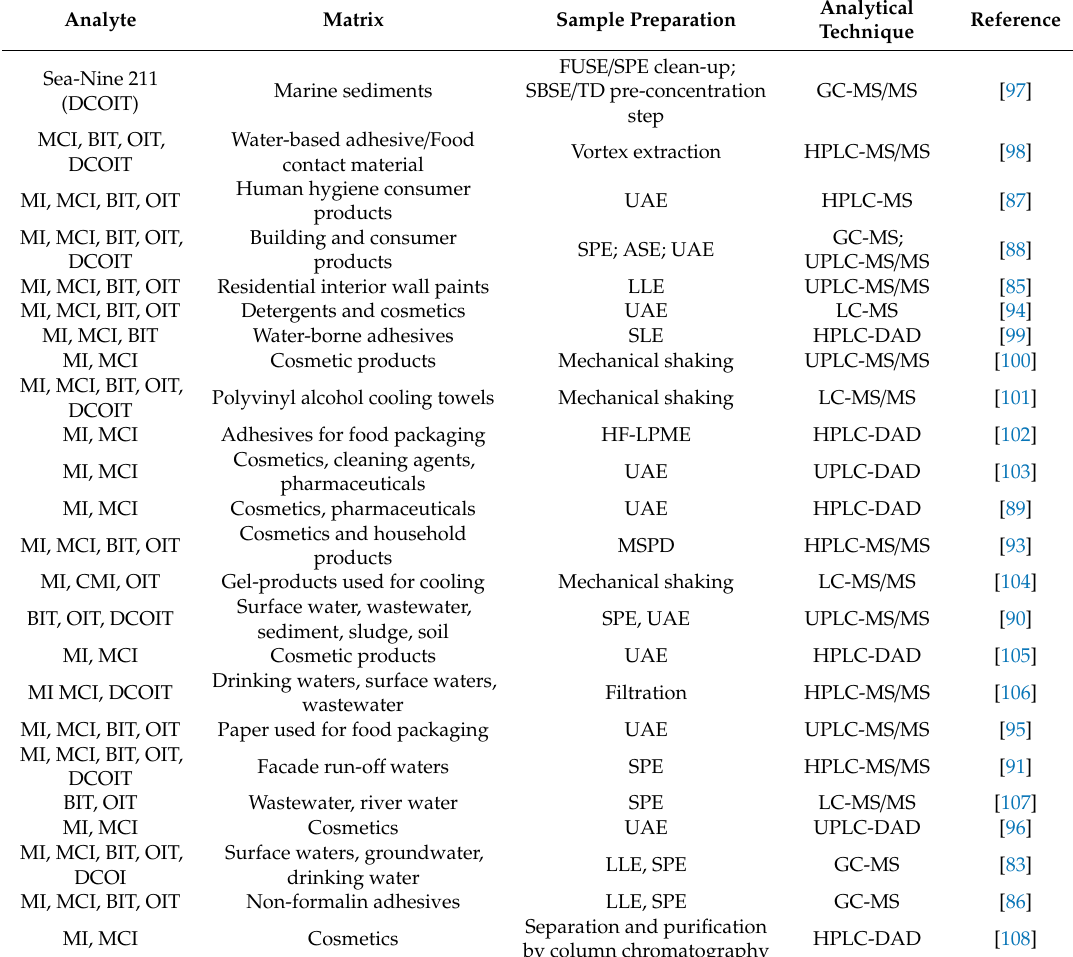
Table 5. Analytical methods for isothiazolinones determination in di ff erent